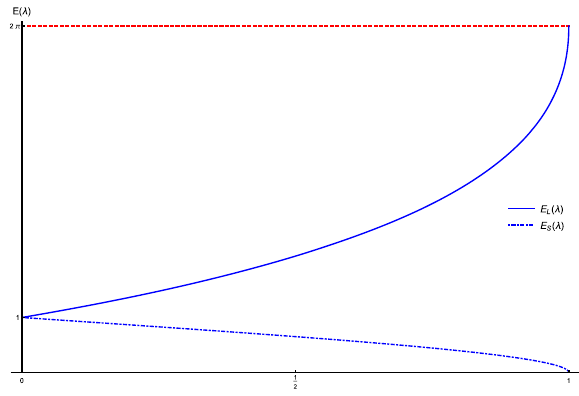
Fig. 5 The energy density (32) for some values of λ . Here one notes how ρ S ,λ behaves as λ → 1, becoming more delocalized, disappearing at λ = 1